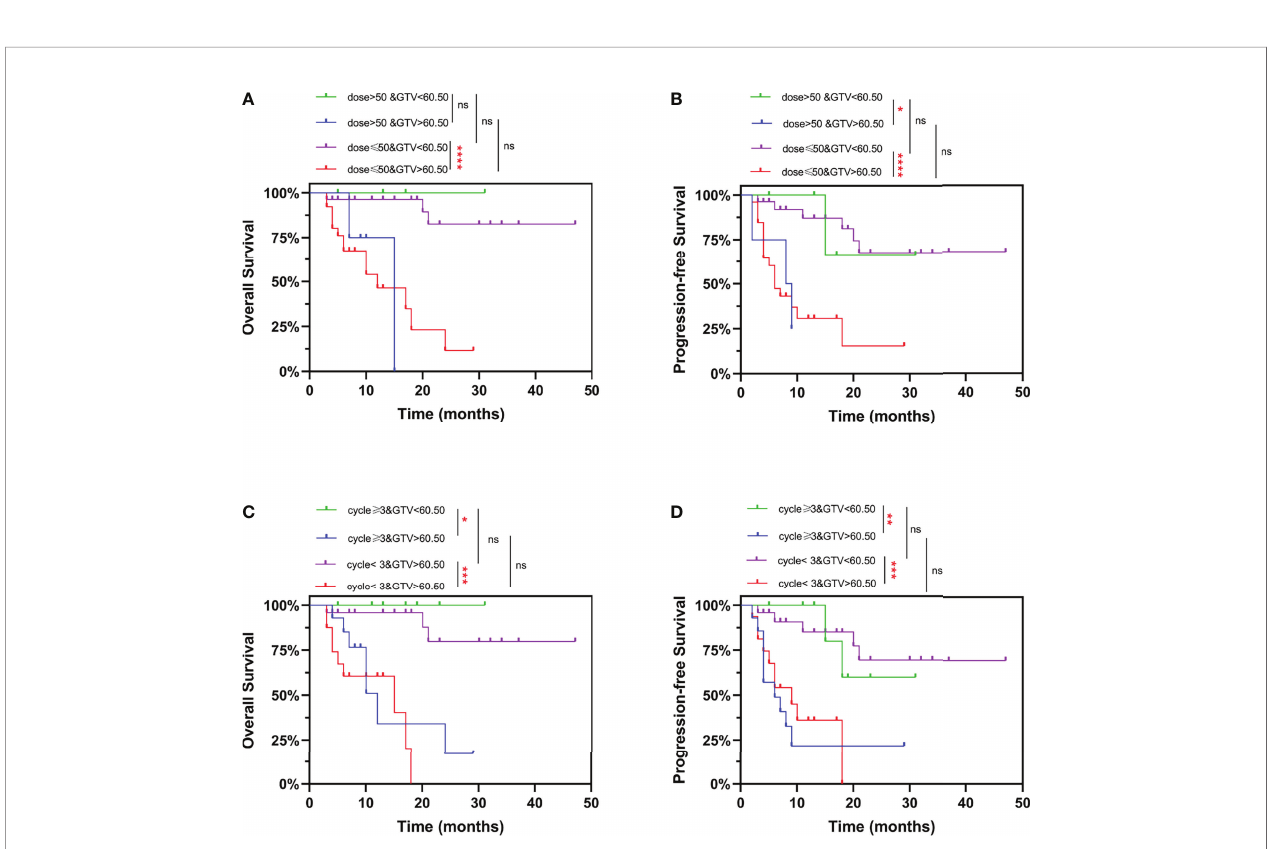
FIGURE 6 | Kaplan-Meier curves for overall survival and progression-free survival strati fi ed by GTV and radiation dose/number of chemotherapy cycles. Curves are shown for overall survival strati fi ed by GTV and (A) prescription dose, or (C) number of chemotherapy cycles. Curves are shown for progression-free survival strati fi ed by GTV and (B) prescription dose, or (D) number of chemotherapy cycles. ns, P > 0.05, *P < 0.05, **P < 0.01, ***P < 0.001, ****P < 0.0001 by log-rank test. GTV, gross tumor